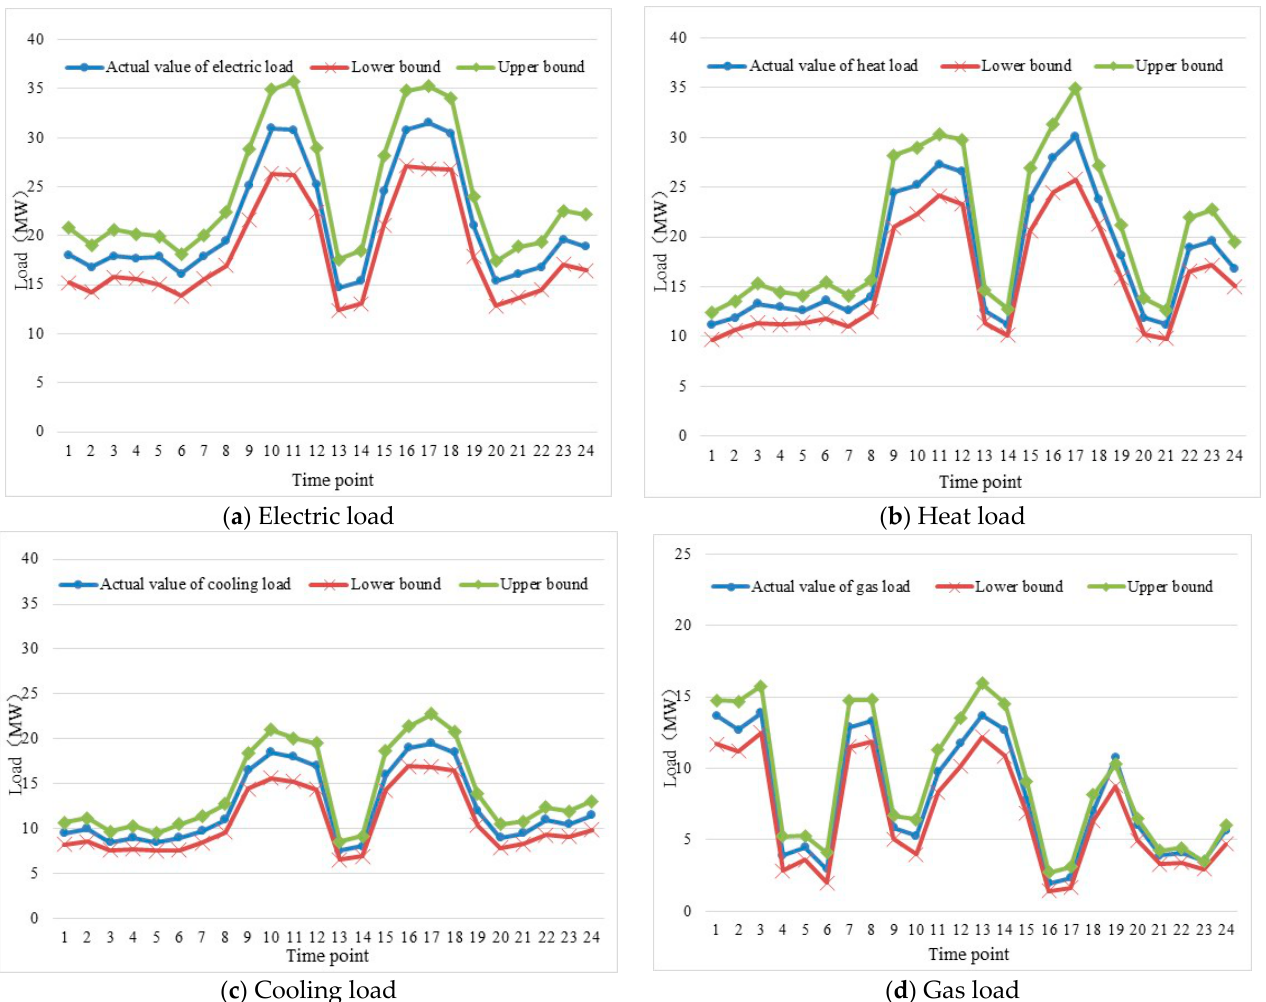
Figure 13. Multi-energy load forecast results on the workday based on the STL method.